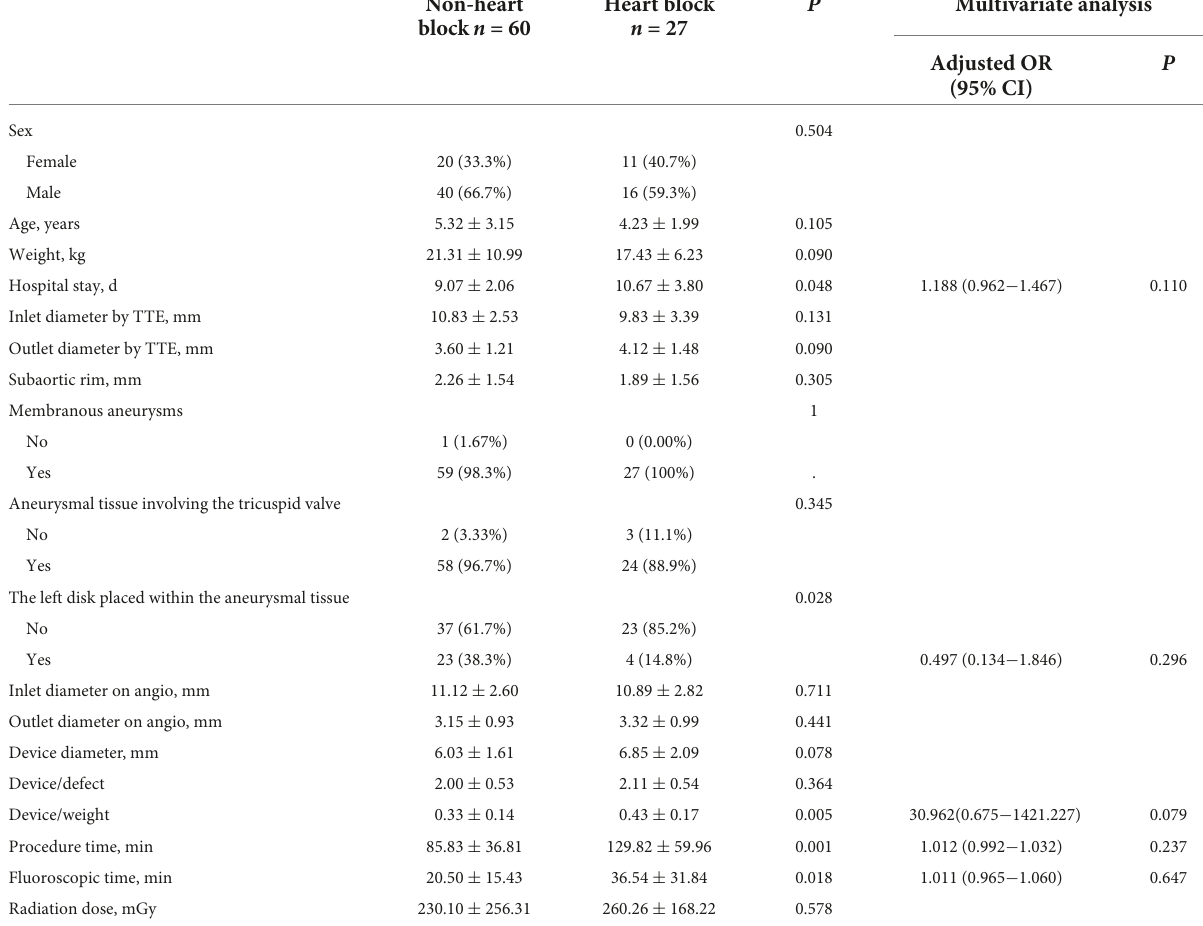
TABLE 8 Risk factors for occurrence of heart block in patients using thin-waist